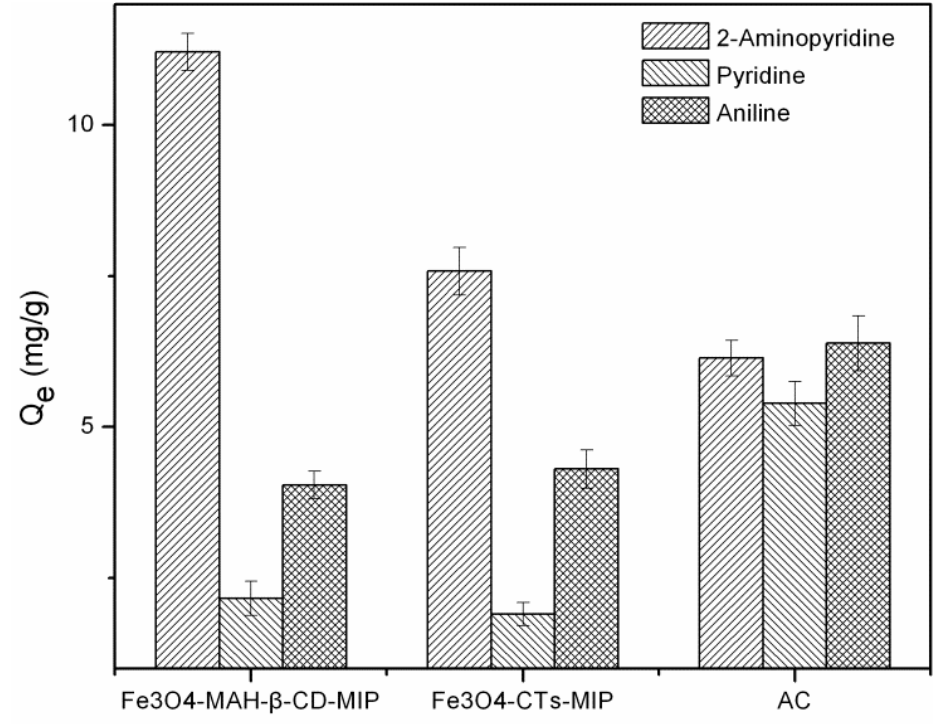
Figure 13. Selective adsorption performance of spiked water with different sorbents.